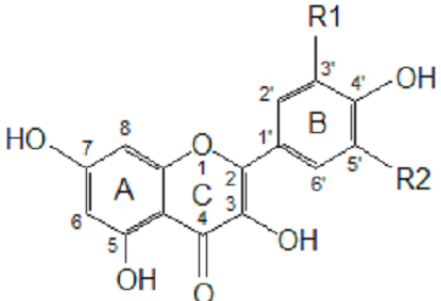
Figure 2. Flavonoid skeleton showing rings A, B and C and the numbering. Kaempferol, R1= H, R2=H; quercetin, R1= OH, R2= H; myricetin, R1=OH, R2=